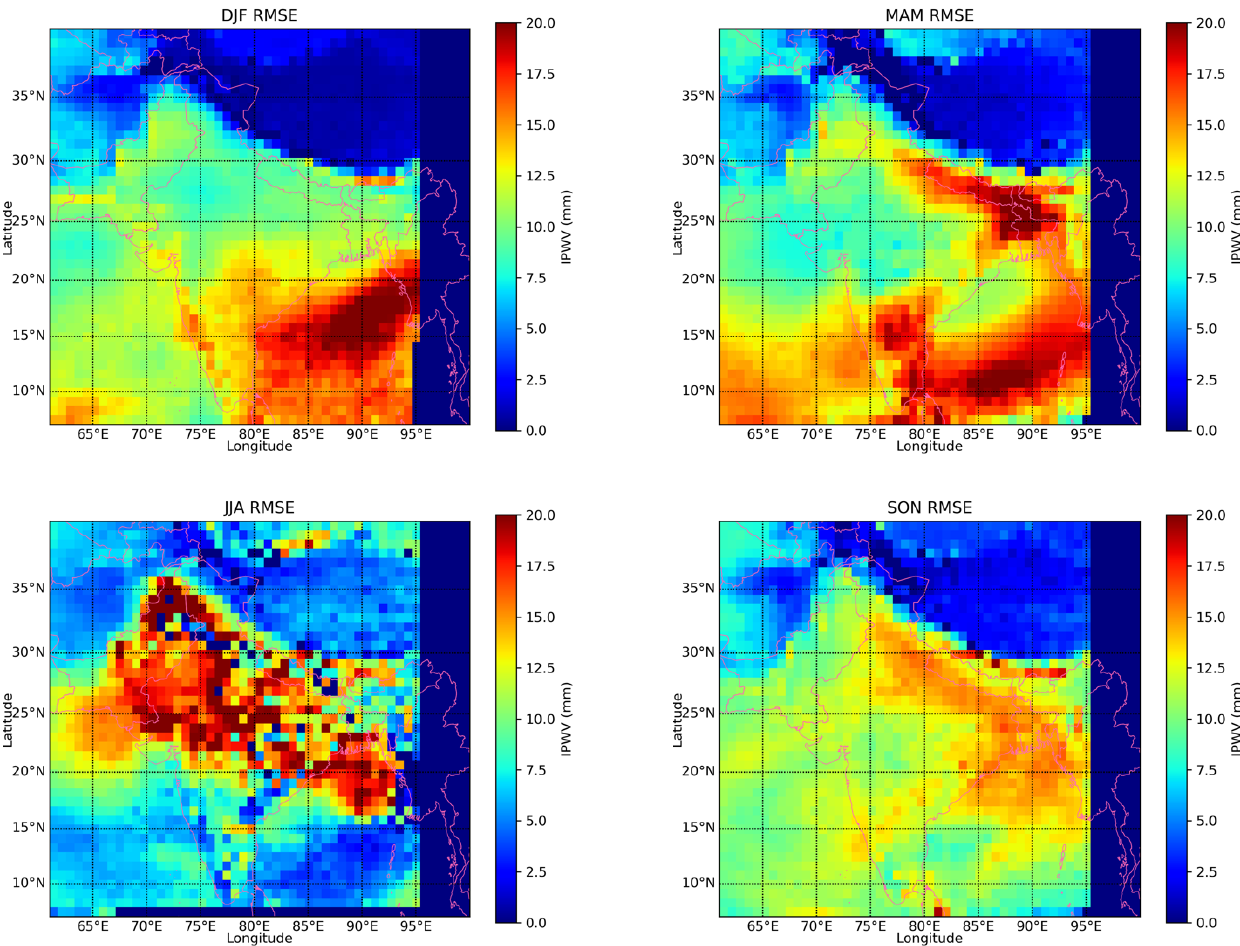
Figure 8. Seasonal RMSE between CAMS and INSAT-3DR.